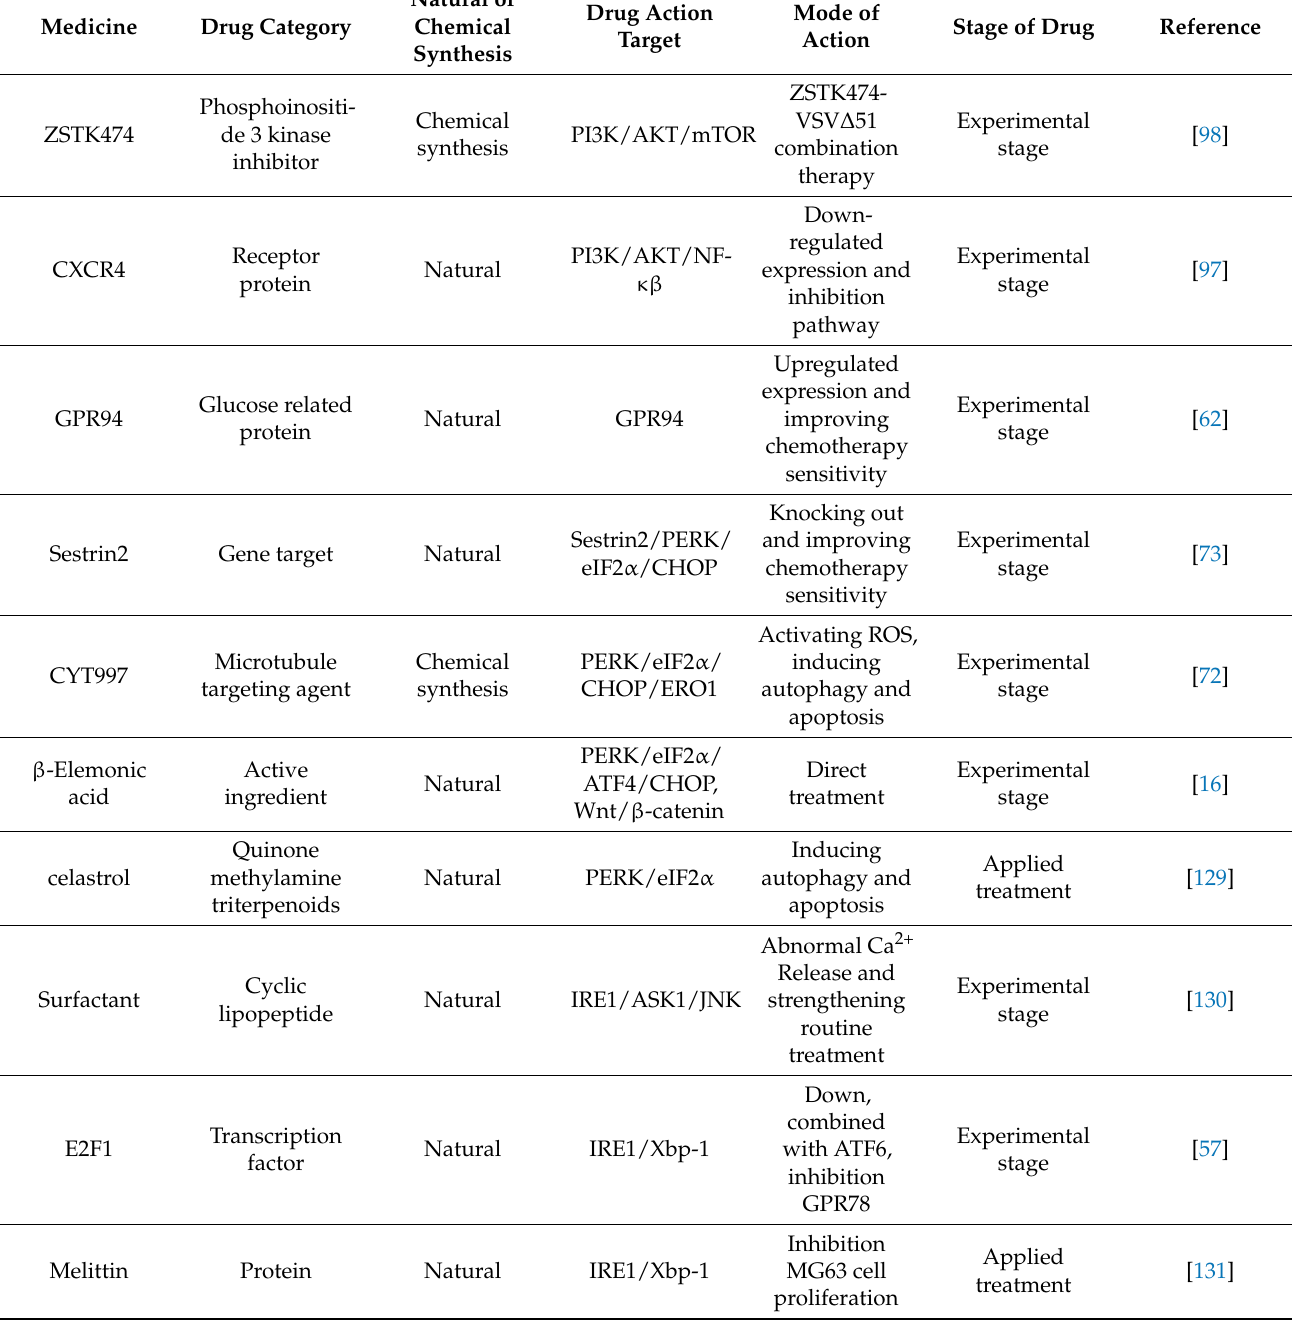
Table 1. Drugs or genetic targets associated with ERS for the potential treatment of